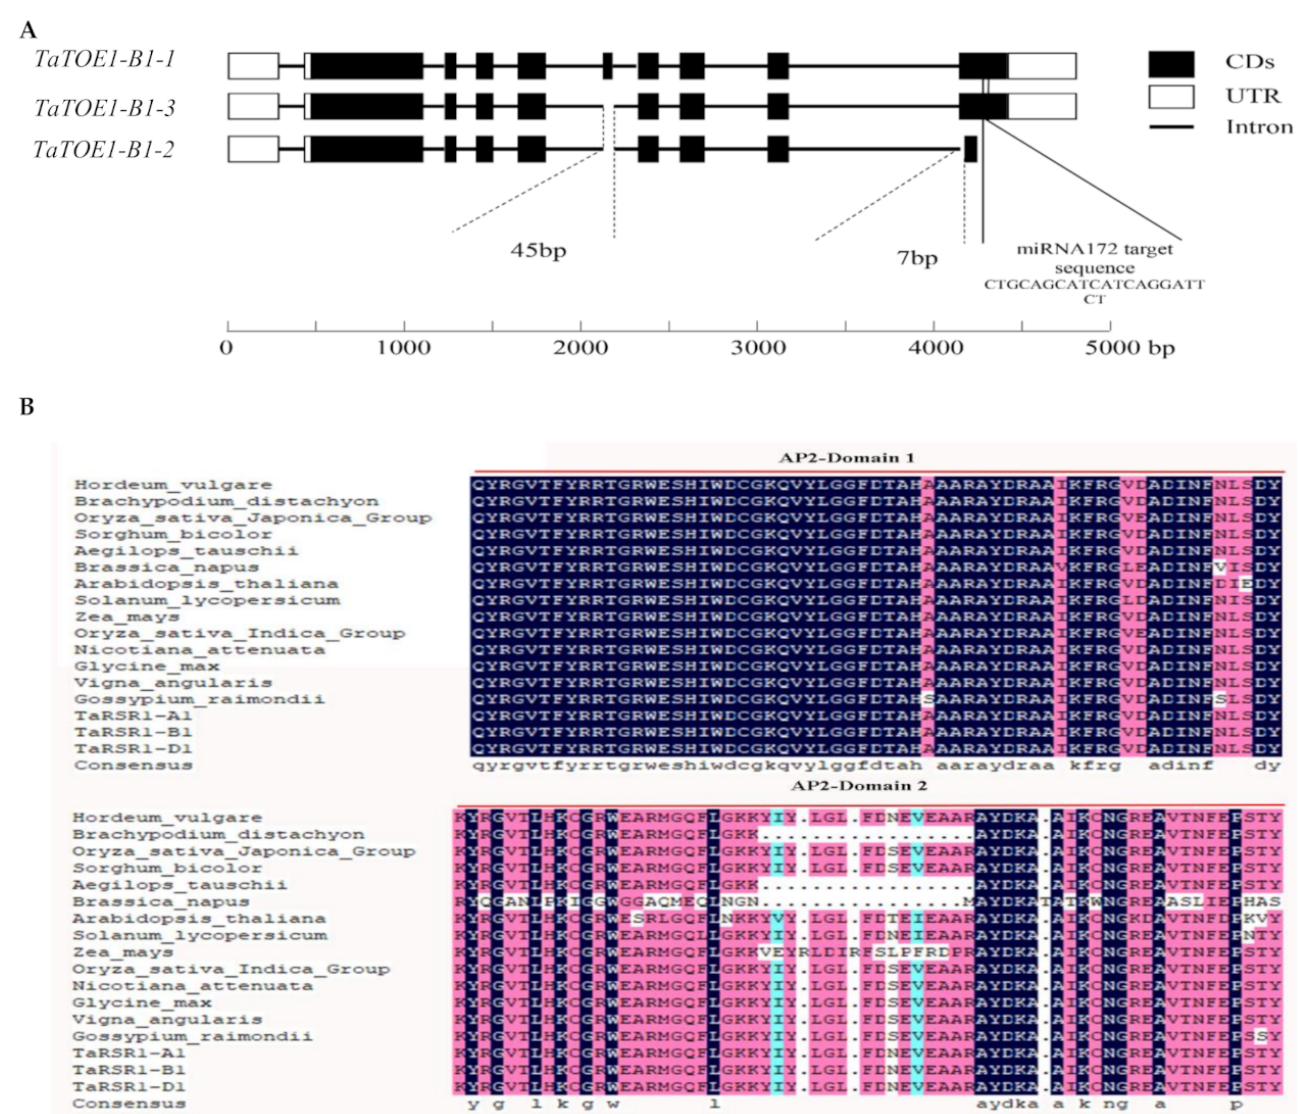
Figure 1. Gene structure analysis and protein sequence alignment. ( A ) Gene structure analysis of TaTOE1-B1-1 , TaTOE1- B1-2 , and TaTOE1-B1-3 . Dotted line shows relative locations where differences between transcripts appear; solid line shows relative locations of miRNA172 target; ( B ) AP2 domain sequence alignments of TaTOE1 homologous proteins in different